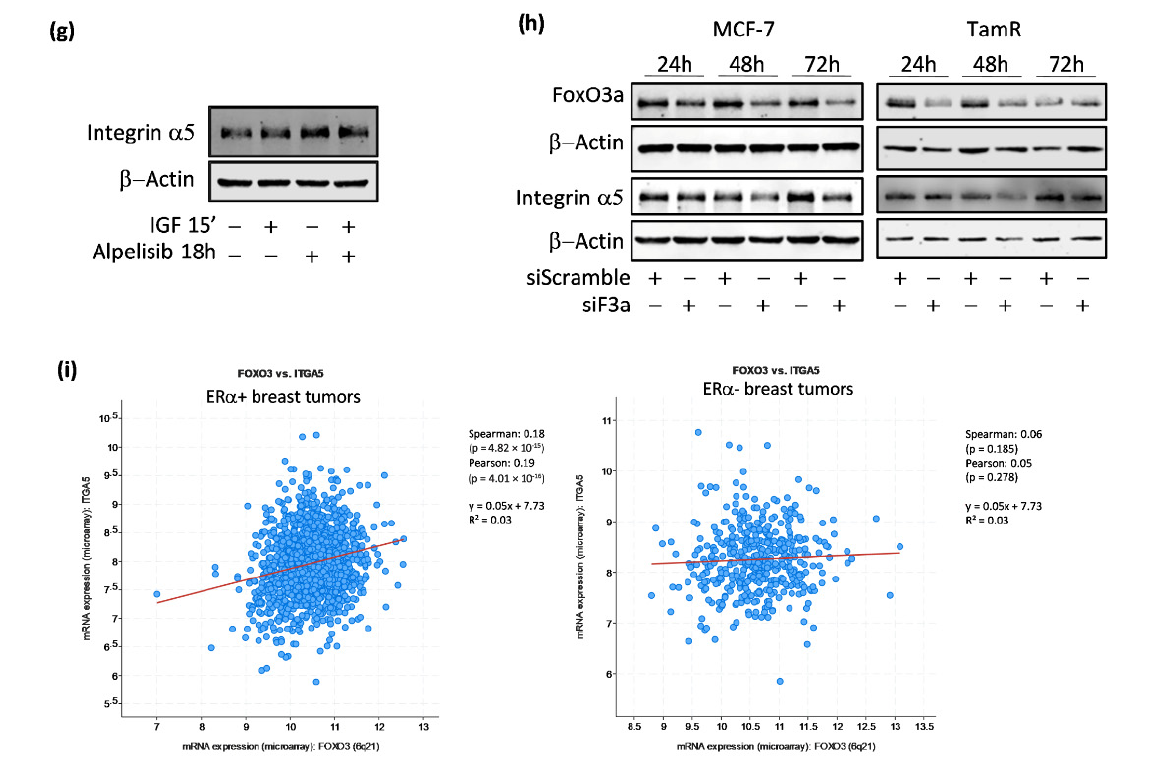
Figure 3. FoxO3a modulates integrin α 5 expression in BC. ( a ) WB analysis was conducted on 10 μ g of total lysates from TamR and MCF-7 parental cells to detect indicated proteins. β -Actin was used as a loading control. A double set of cells was transfected in suspension with F3aAAA and pcDNA3.1 plasmids for 48 h. FoxO3a and integrin α 5 expression was assessed at the ( b ) RNA and ( c ) protein level. mRNA content was normalized vs. the relative 18S rRNA content, and GAPDH was employed for loading controls. ( d ) 30 μ g of total proteins extracted from TamR/TetOn-AAA-